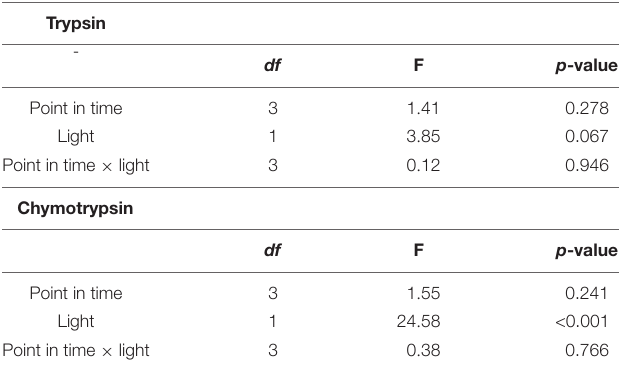
TABLE 1 | Results of the two-way ANOVA for trypsin and chymotrypsin activities between different points in time in control or ALAN light conditions ( df = degrees of